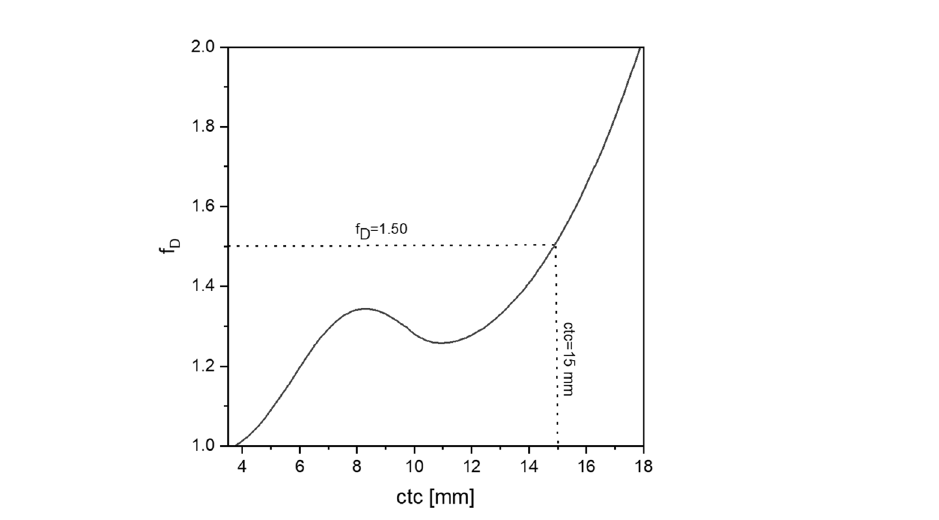
Figure 7. Multiplication factor f D over ctc required to fulfill the minimum criterion D min /D t = 0.975 for 2-dir interlaced planar minibeams. The beam shape was approximated with two Gaussians. The dotted lines mark the optimum found according to the calculated cell survival curves at the close tumor